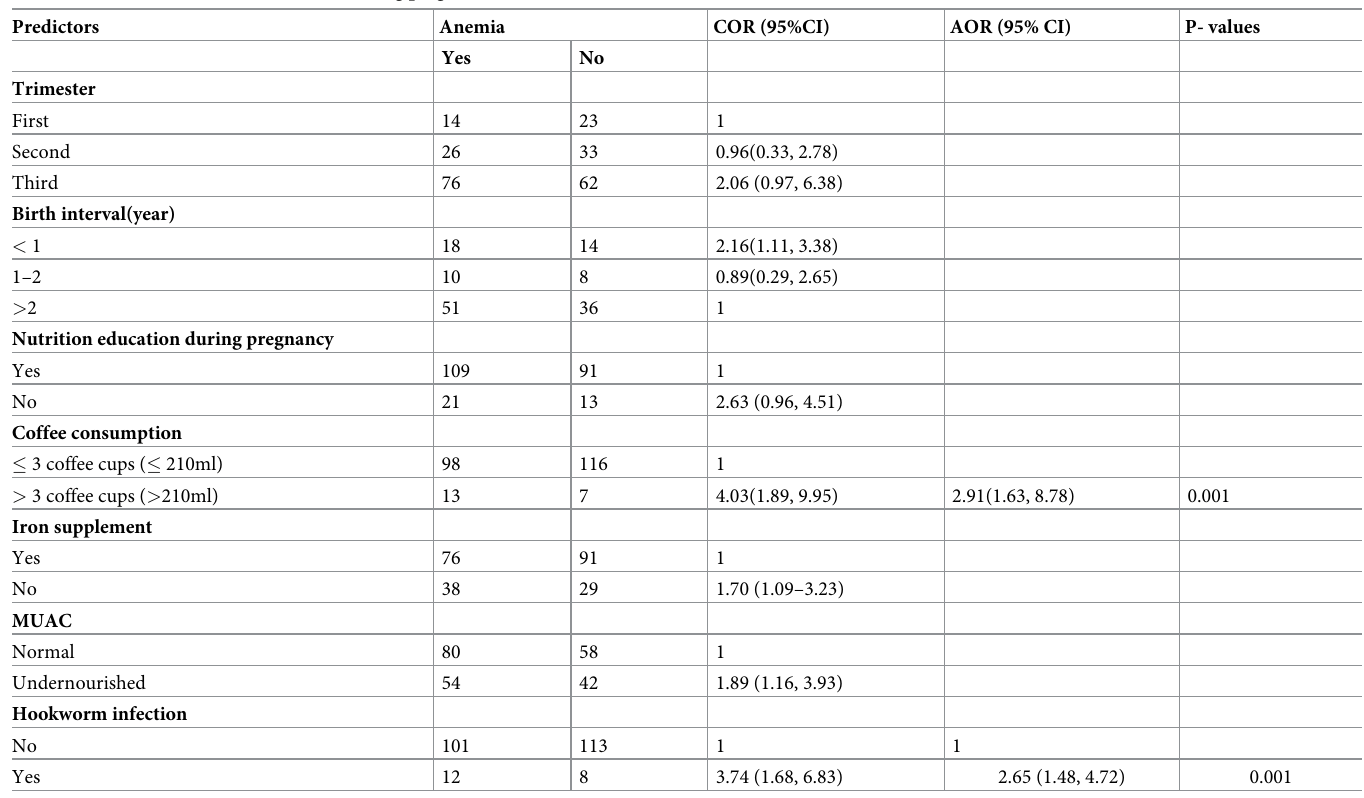
Table 6. Factors associated with anemia among pregnant